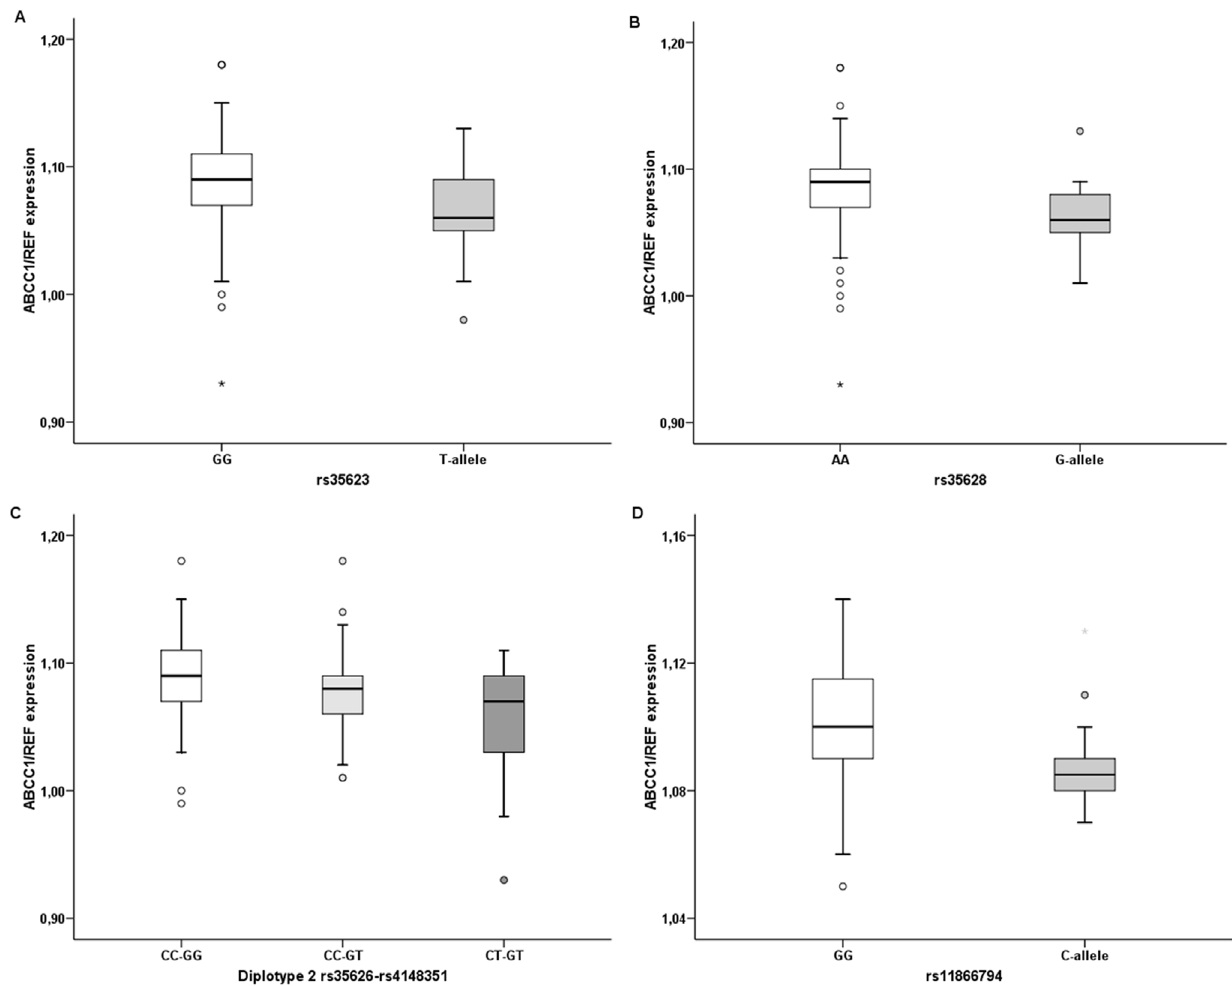
Figure 3. Significant associations between transcript levels and polymorphisms in ABCC1 . All SNPs and frequent diplotypes were analyzed but to retain concise style only significant associations are reported.